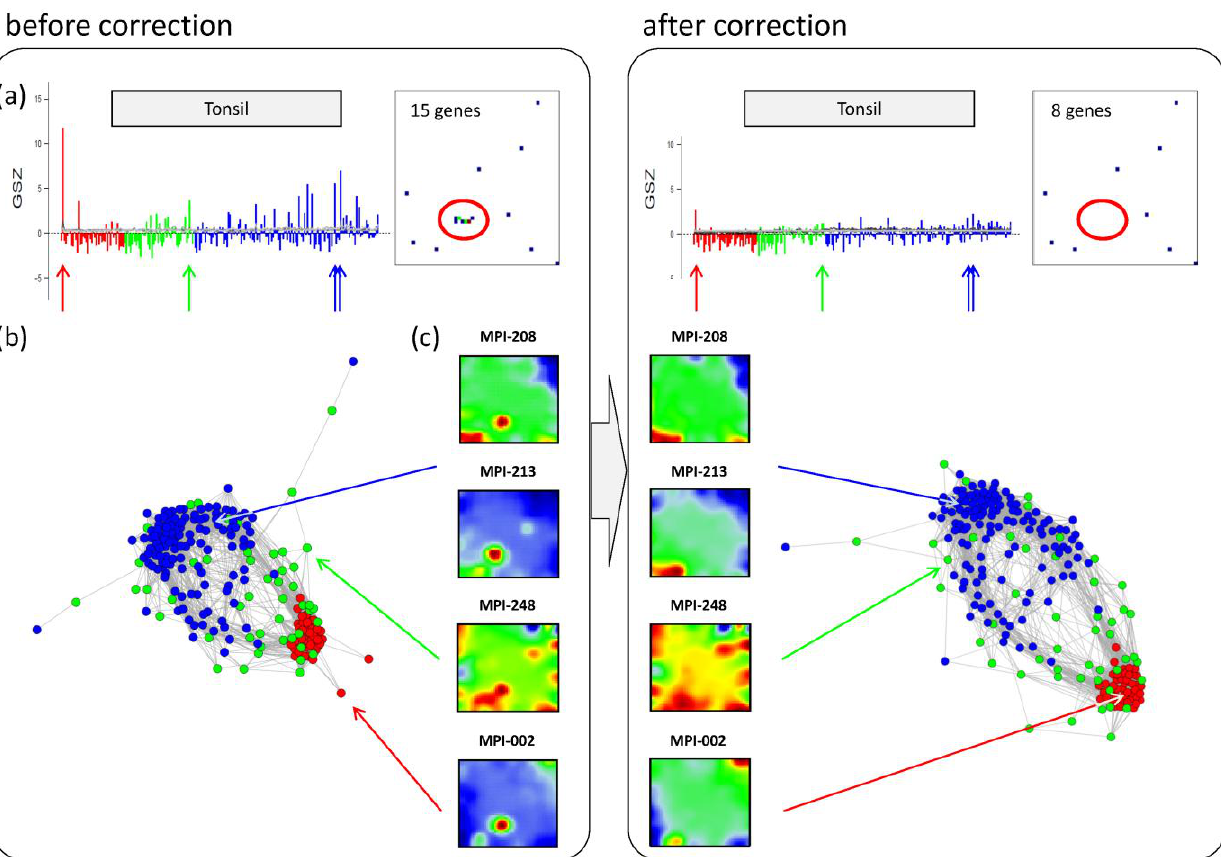
Figure 6. Correction of outlier samples contaminated with healthy lymph node tissue. The left and right parts of the figure refer to the uncorrected and corrected data, respectively. ( a ) GSZ-profile and population map of the (cid:181)(cid:87)(cid:82)(cid:81)(cid:86)(cid:76)(cid:79)(cid:182) gene set: The signature is not characteristic for one of the subtypes and their genes accumulate in spot (cid:181)(cid:54)(cid:182) of the map. ( b ) Correlation network of the lymphoma data set. ( c ) SOM portraits of selected outlier samples. The arrows point to the position of these samples in the CN and in the GSZ-profile. After correction,